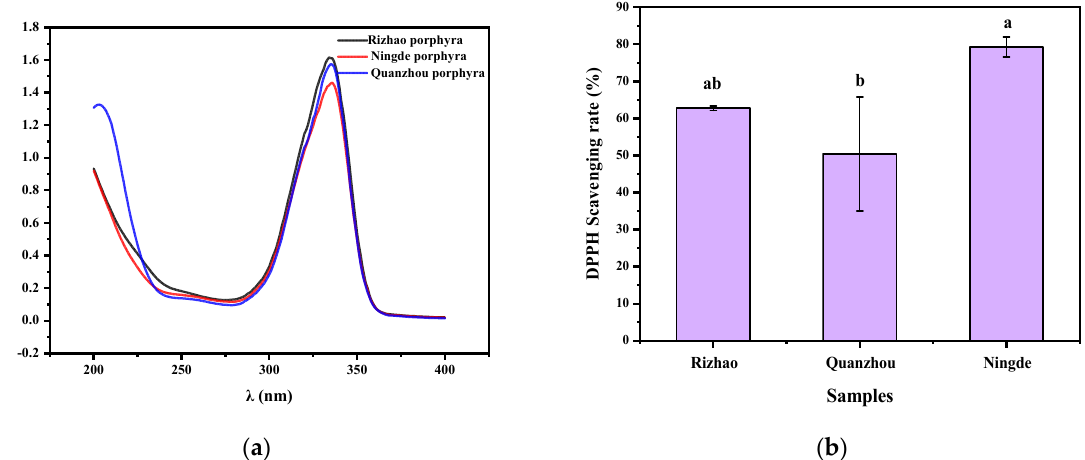
Figure 1. ( a ) The maximum absorption wavelength of extractions in the UV region. ( b ) DPPH free radical scavenging activities of MAAs.